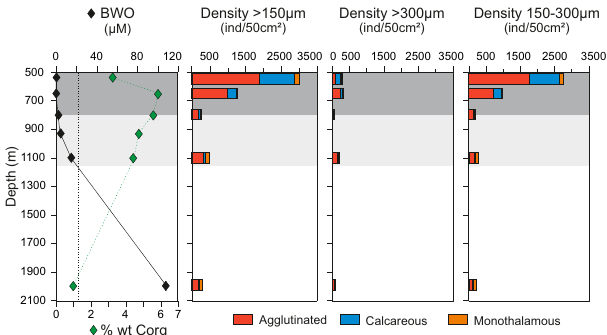
Figure 2. Total stained foraminiferal abundances (ind/50cm 2 ) in the 150–300µm, >300µm and >150µm (i.e. 150–300 and >300µm combined) fractions of the first centimetre (0–1cm layer) along the sampling transect. The BWO concentration (µM) and C org content (wt.%) are from Hunter et al. (2012) and Cowie et al. (2014). The vertical dashed line corresponds to the 22µM limits defining an OMZ according to Levin et al. (2003). The dark-grey shadow repre- sents the core of the OMZ (<2µM; Paulmier and Ruiz-Pino, 2009) and the light-grey shadow the lower part of the OMZ (2–22µM; Levin,